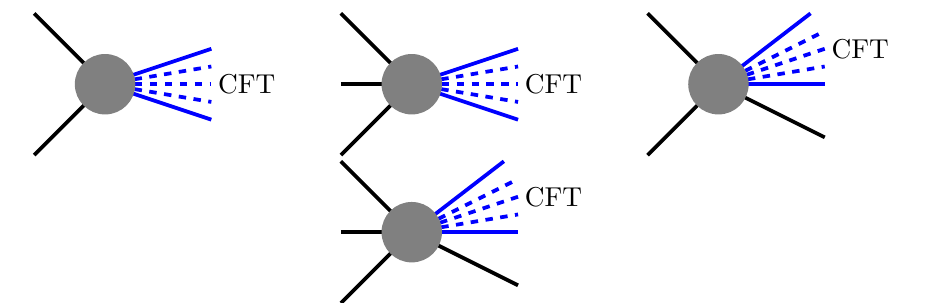
Figure 1 . Relativistic freeze-in. A list of processes relevant for the population of the DS CFT from SM initial states (black lines). Notice that we also include reactions where a SM field is present in the final states and/or more than two SM particles are present in the initial